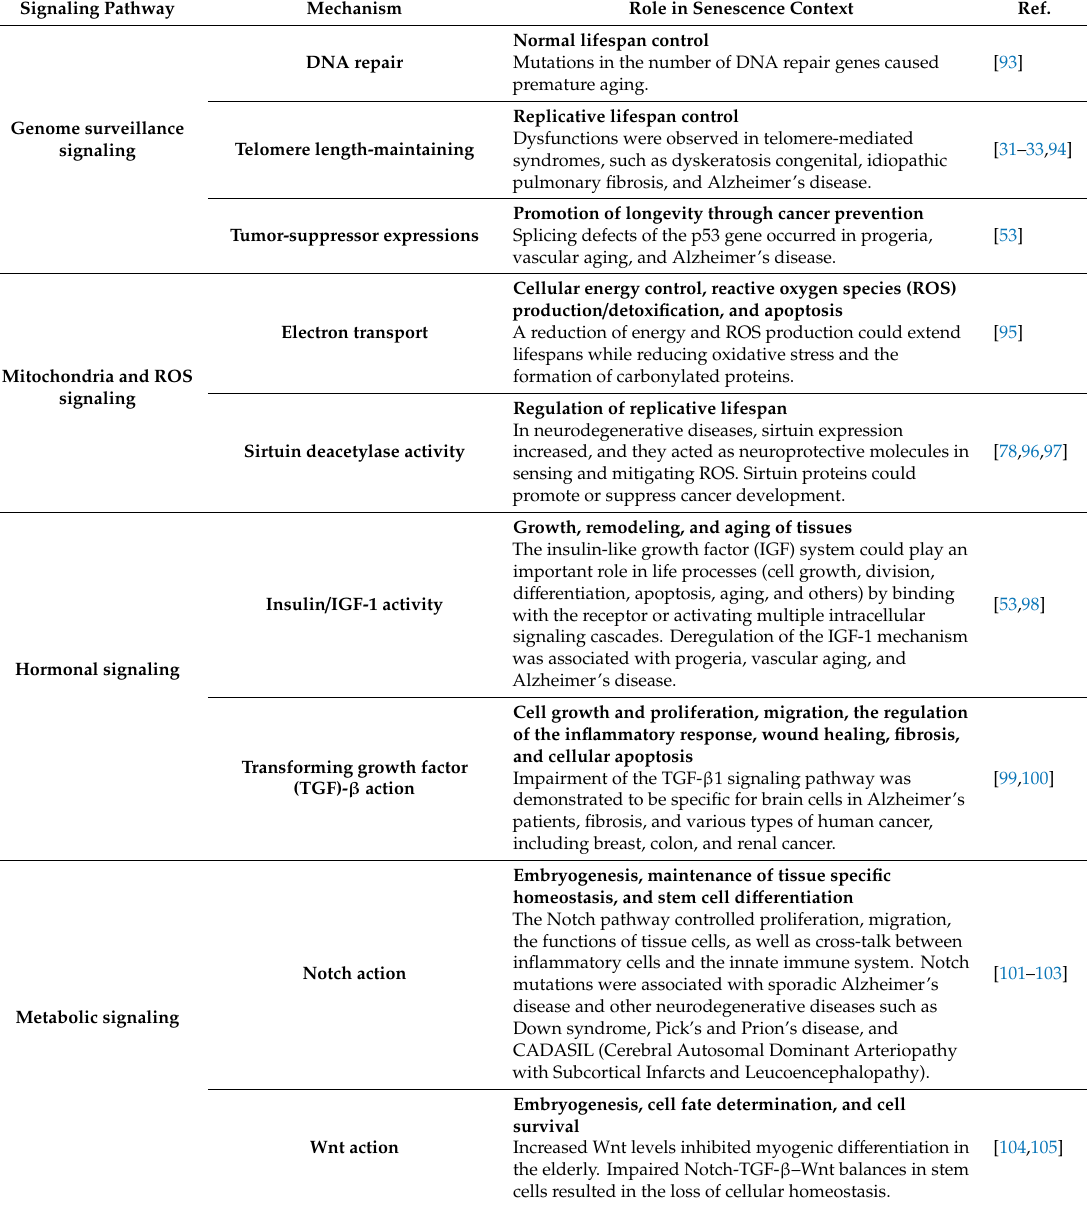
Table 1. Signaling pathways and mechanisms involved in